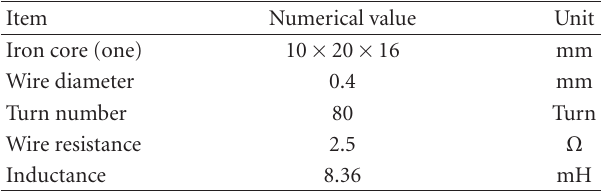
Table 2: Specifications of linear induction motor.